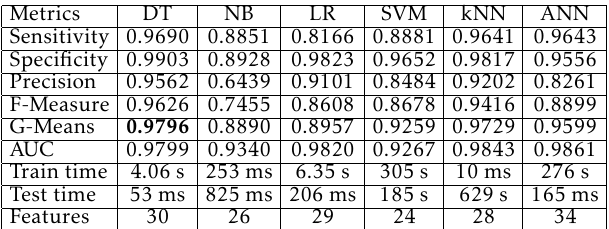
Table 24. Results of using GR-BFE algorithm on